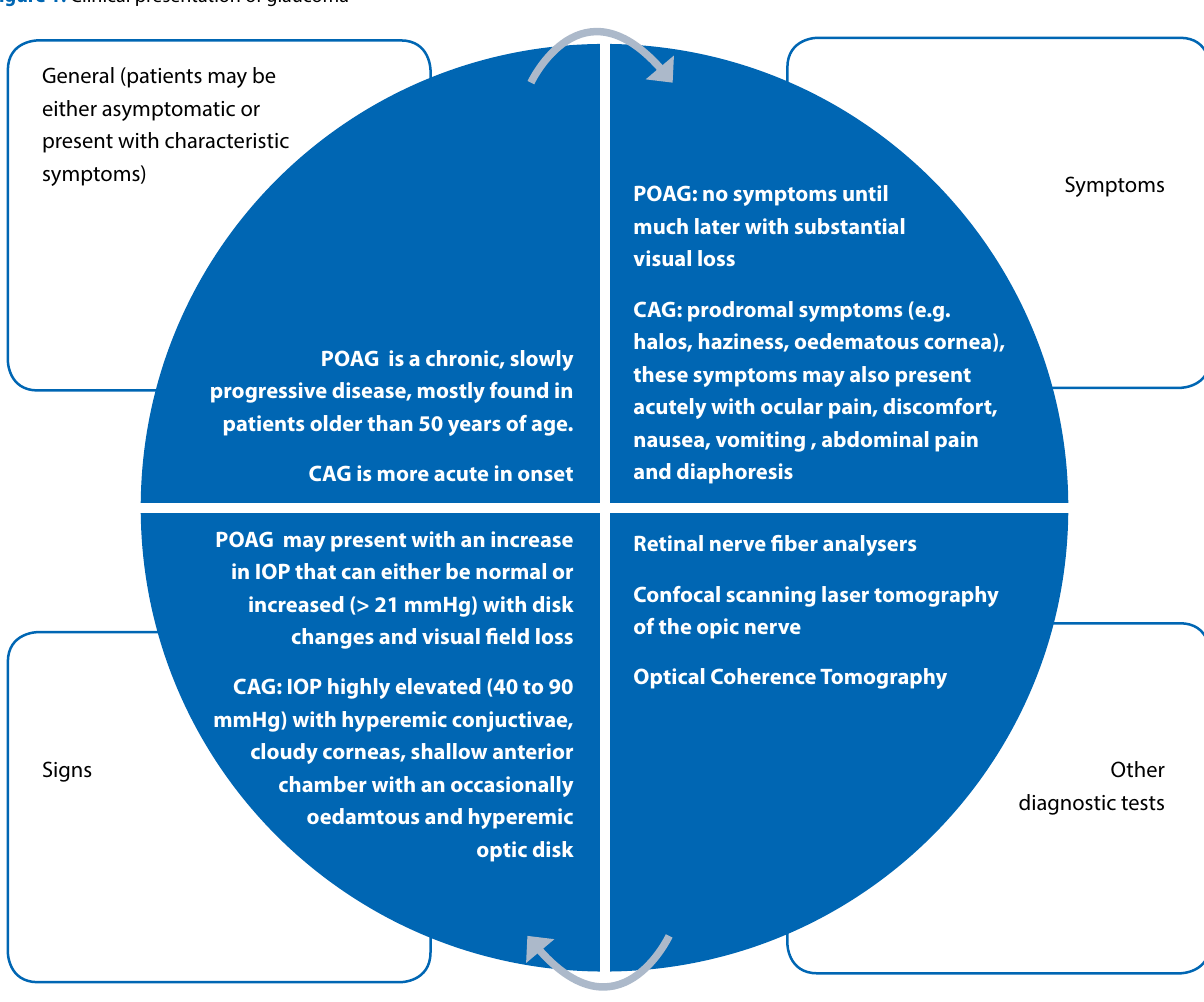
Figure 1. Clinical presentation of glaucoma